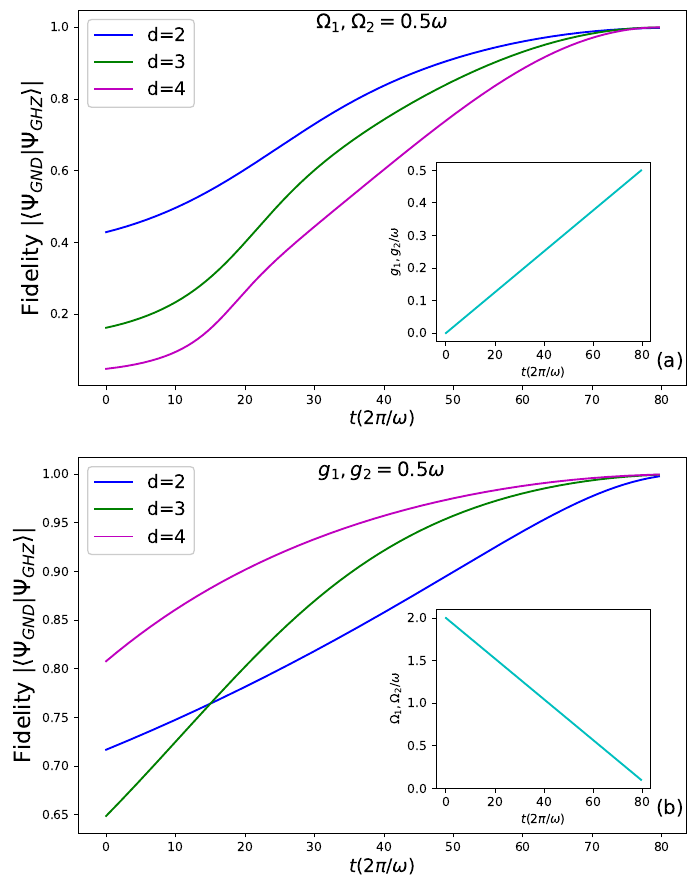
Figure 7: Adiabatic state preparation of the GHZ state in the qubit, qutrit, and ququart cases. (a) Time evolution of the fidelity between the instantaneous state and the hybrid GHZ state in Eq.(13). The coupling terms g switched on at t = 0 and linearly increased to 0.5 ω , as shown in the inset. (b) State fidelity with the GHZ state vs time in the adiabatic process where the atoms frequen- cies are linearly reduced from the initial value Ω the